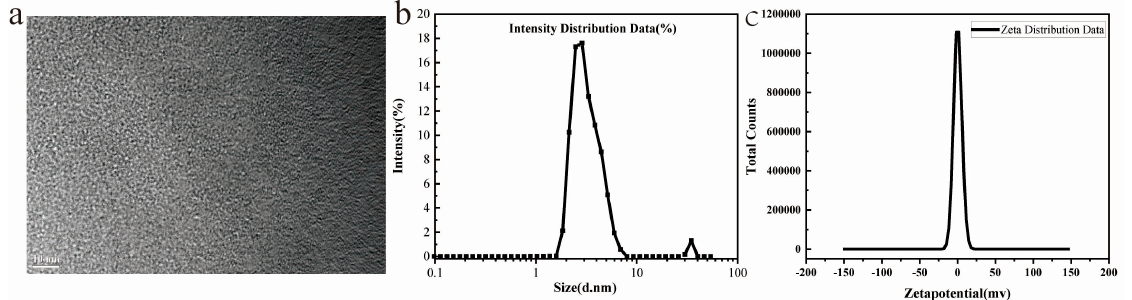
Figure 1. TEM ( a ), DLS ( b ), and zeta potential ( c ) of RTPL